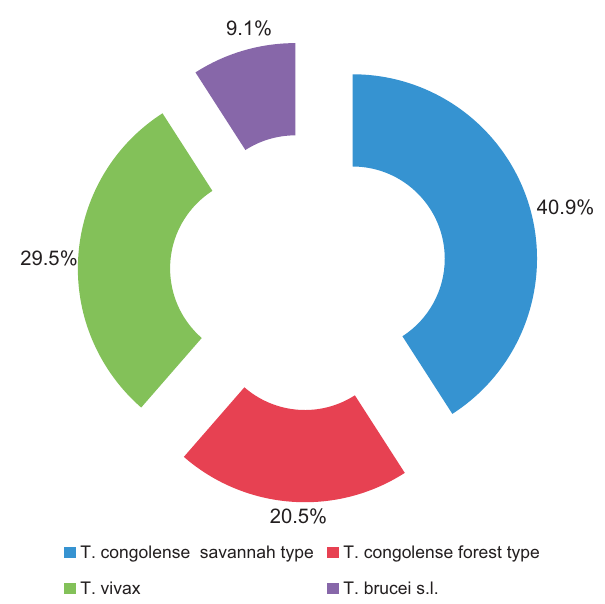
Figure 2. Proportions of trypanosome types circulating along Comoé River in Côte d’Ivoire.